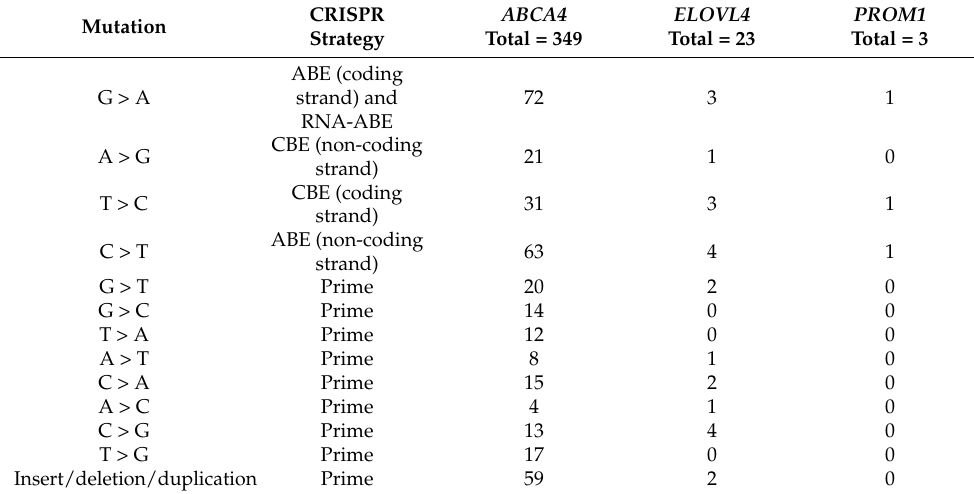
Table 3. Summary of the different types of mutations that cause Stargardt disease. Data were extracted from ClinVar (June 2021) and only included mutations confirmed as pathogenic or likely path-ogenic with evidence of clinical phenotype. Numbers represent the different occurrences of each mutation type; for example, of 349 different ABCA4 mutations, 72 were G > A transitions. ABE = adenine base editor, CBE = cytosine base